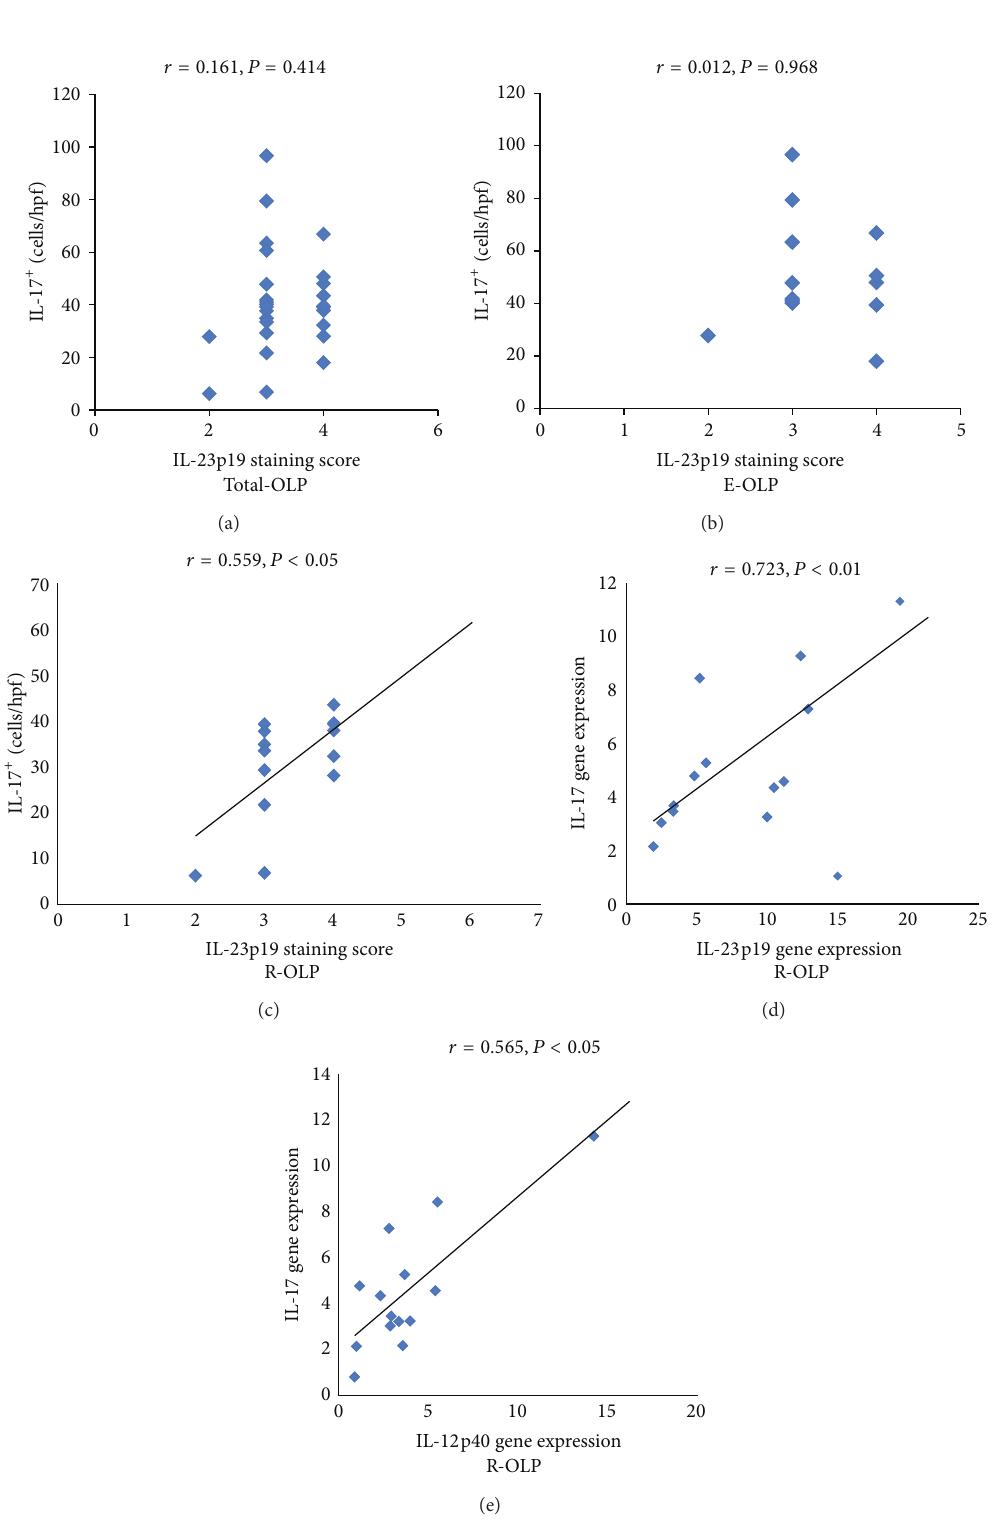
Figure 3: Correlation between the expressions of IL-23 and IL-17 in OLP tissue specimens. (a–c) Correlations between the staining scores of IL-23p19 and numbers of IL-17+ cells per hpf in total OLP tissue specimens ( 𝑛 = 27 , 𝑟 = 0.161 , 𝑃 > 0.05 ), erosive OLP tissue specimens ( 𝑛 = 13 , 𝑟 = 0.012 , 𝑃 > 0.05 ) and reticular OLP tissue specimens ( 𝑛 = 14 , 𝑟 = 0.559 , 𝑃 < 0.05 ). (d-e) Correlations between the mRNA expressions of IL-23p19 ((d) 𝑟 = 0.723 , 𝑃 < 0.01 ) or IL-12p40 ((e) 𝑟 = 0.565 , 𝑃 < 0.05 ) and IL-17 in reticular OLP tissue specimens ( 𝑛 = 14